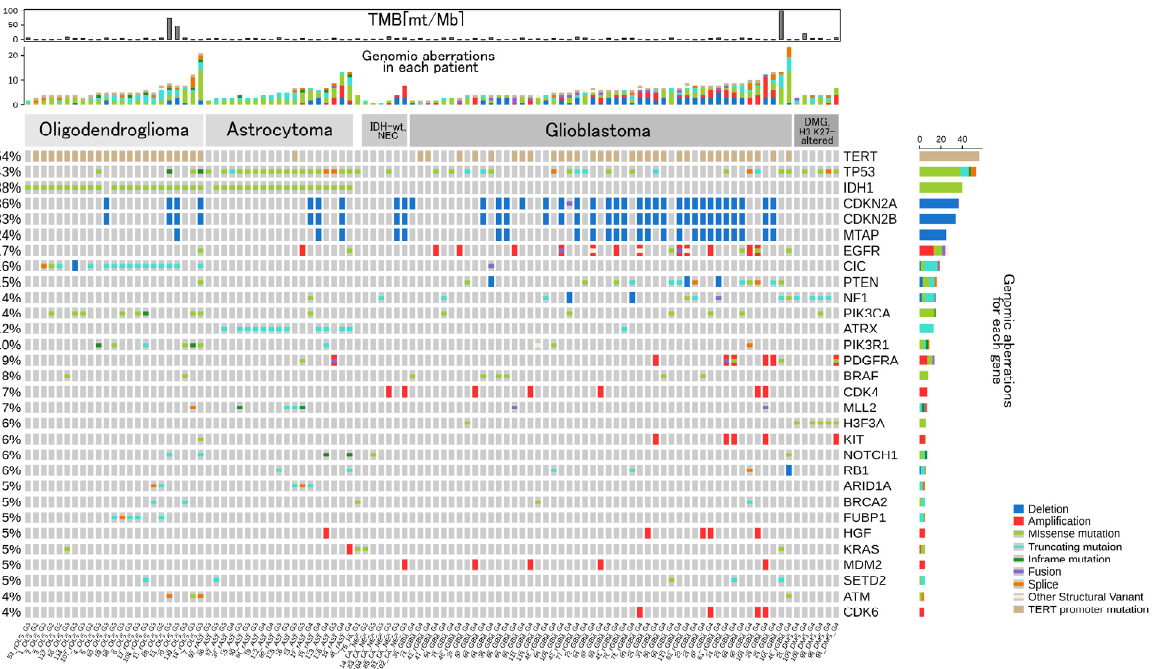
Figure 1. Oncoprint illustrating genomic aberrations observed in 104 patients with glioma using a comprehensive genomic profiling test (CGPT). The top 30 most frequently reported genes are displayed, and their type of genomic aberrations are categorized as follows by their colors: Deletion, Amplification, Missense mutation, Truncating mutation, Inframe mutation, Fusion, Splice, Other Structural Variant, and TERT promoter mutation. The number of genomic aberrations for each case and gene is displayed at the middle row and the right of the oncoprint, respectively. At the top, the tumor mutation burden (TMB, [mutations/Mb]) score for each patient is shown. ID for each patient is shown at the bottom. For the cases with an unavailable TMB score, TMB is shown as − 1. See also Figure S1a. for a full genomic display.